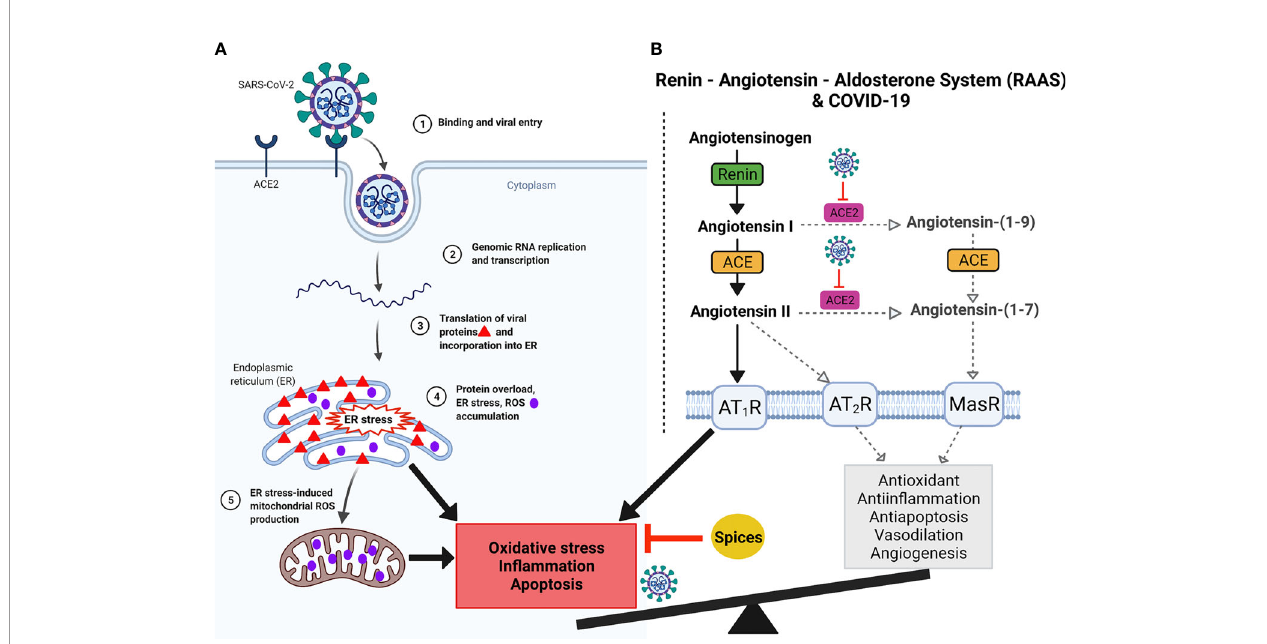
FIGURE 4 | Graphical demonstration of predicted SARS-CoV-2 infection, ACE2 blockage, oxidative stress, and RAAS imbalance. (A) Binding of SARS-CoV-2 to ACE2 (1) followed by profuse replication, transcription and translation (2) of SARS-CoV-2 in the host cell leads to endoplasmic reticulum (ER) stress due to accumulation of newly synthesized viral proteins in the ER (3). Protein overload in the ER leads to reactive oxygen species (ROS) generation in the ER (4). Further, ER stress also induces mitochondrial ROS production (5). Together, ER stress and ROS accumulation lead to in fl ammation and apoptosis. (B) Renin, angiotensin and aldosterone together constitute the Renin-Angiotensin-Aldosterone System (RAAS) and its imbalances in SARS-CoV-2 infection. Angiotensinogen is produced in the liver and cleaved by renin to form angiotensin (I). Angiotensin I is converted to angiotensin II by angiotensin-converting enzyme (ACE). This conversion occurs in the lungs, where ACE is expressed by vascular endothelial and lung epithelial cells. During homeostasis, Angiotensin I is acted upon by ACE2 to generate Angiotensin- (1-9), which is cleaved by ACE to generate Angiotensin-(1-7). Further, ACE2 also cleaves Angiotensin II into Angiotensin-(1-7). Angiotensin-(1-7) via Mas receptor mediates antioxidative and anti-in fl ammatory responses. Angiotensin II binds to one of two G-protein coupled receptors, the AT 1 and AT 2 receptors. SARS-CoV2 binding to its potent ACE2 receptor diminishes ACE2 function, skewing the ACE/ACE2 equilibrium to a predominant pro-in fl ammatory ACE-Ang II-AT 1 R axis signaling. Imbalances in the RAAS system can alter the AT 2 R -MasR pathway, which is very important for vasodilation, angiogenesis, anti-in fl ammatory, antioxidative, and antiapoptotic activities. In contrast, AT 1 R pathway is important for vasoconstriction, in fl ammation, oxidative stress, and apoptosis. Virus binding to ACE2 dysregulates AT 2 R-MasR pathway. Imbalances of ACE and ACE2 generate ROS, leading to oxidative stress, which causes hyperin fl ammation. In addition, hyperin fl ammation with cellular oxidative stress imbalances causes disease severity and when reaches its climax leads to respiratory failure as discussed in Figures 1 and 5 . Spices could potentially inhibit in fl ammation and restore homeostasis. Created with